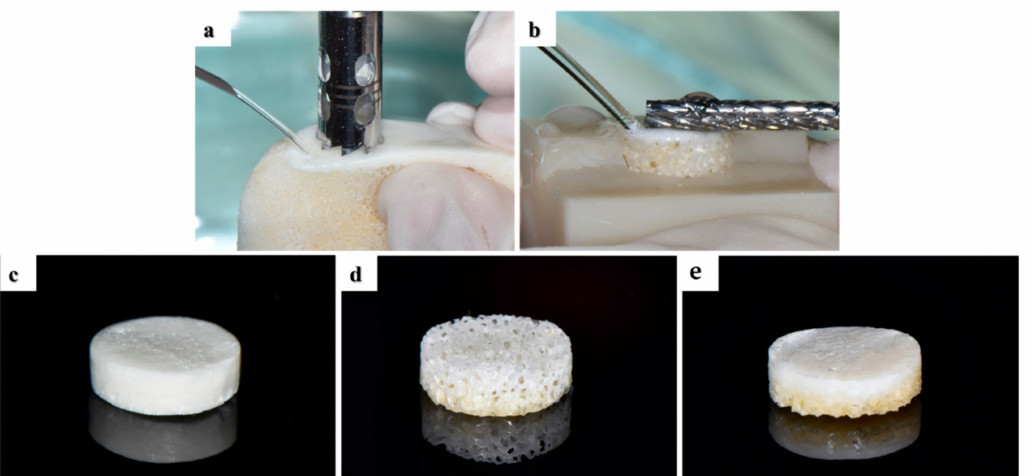
Figure 11. Fabrication of porcine bone blocks. ( a ) Bone block preparation using a trephine bur. ( b ) Flat- tening of cortical bone using a denture bar. Prepared specimens of the ( c ) Cortical, ( d ) Cancellous, and ( e ) 2layer